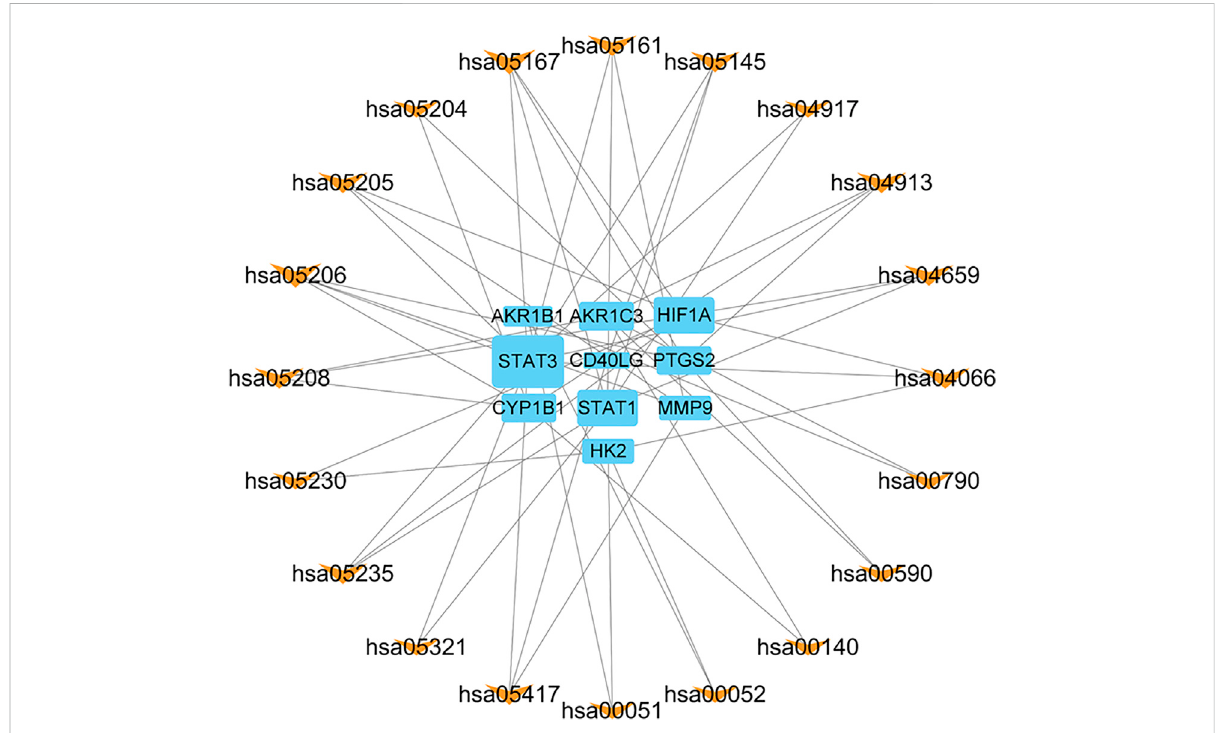
FIGURE 8 Gene – pathway network of FFXST against IS. This network shows the relationship between the enriched 20 pathways and 10 genes. The blue rectangles represent target genes, and the orange V-shapes represent pathways. The size of the graph shows the number of genes or pathways